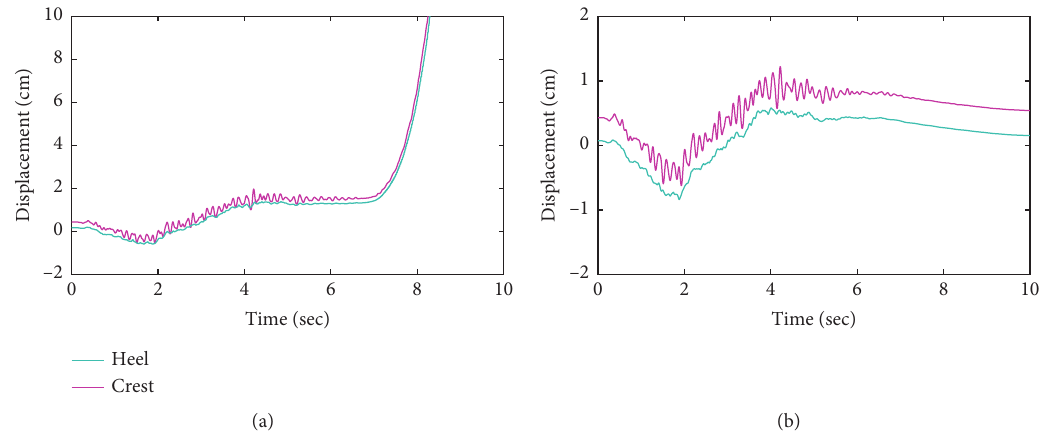
Figure 12: Displacement time history induced by the Swedish design earthquake for the midpoint at the crest and heel of the dam in the stream direction with a Rayleigh damping of 1% (a) and 5%